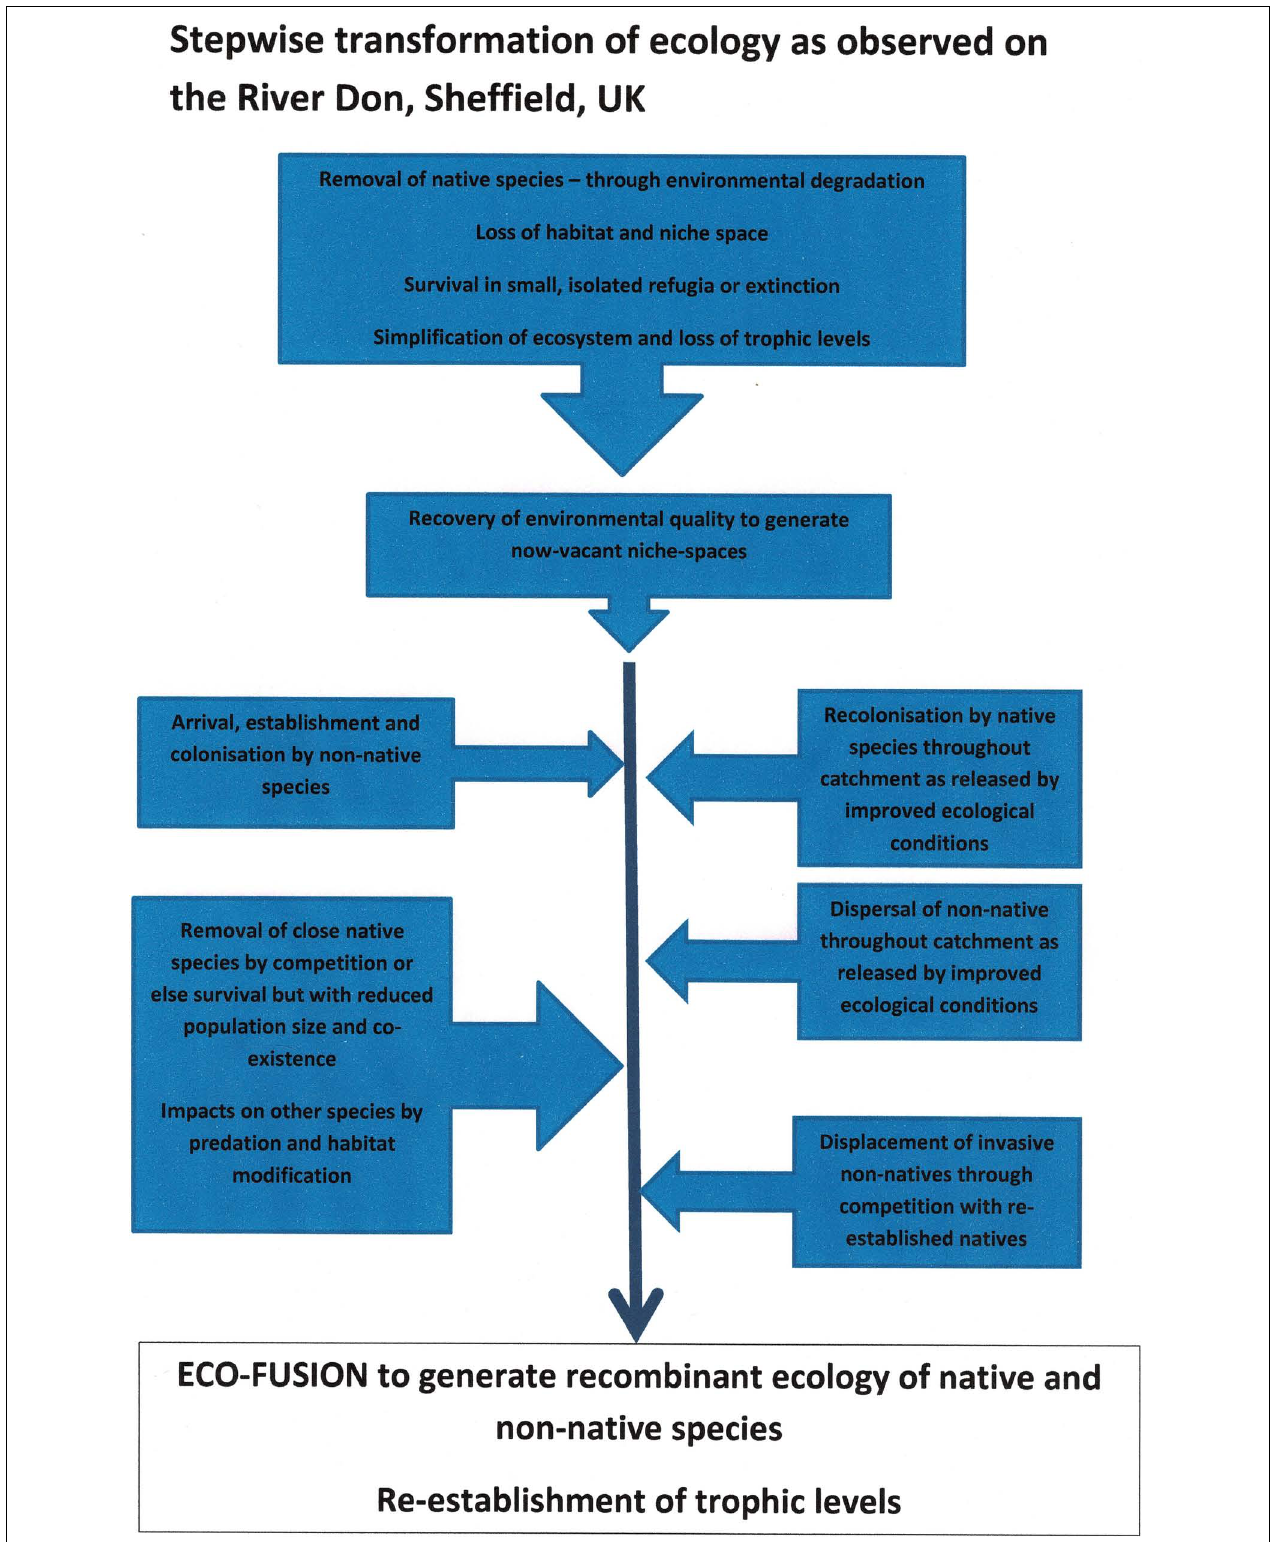
FIGURE 10 | Stepwise transformation of ecology as observed on the River Don, United Kingdom over a period from the 1600s to the 2000s.